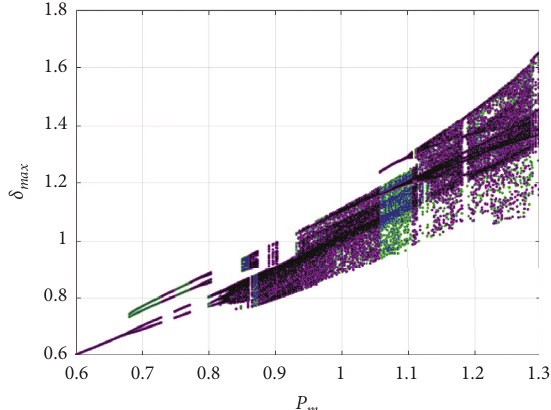
Figure 9: Bifurcation diagram for fractional-order power system (10) with limiter slope equal to 10 and two different initial conditions.